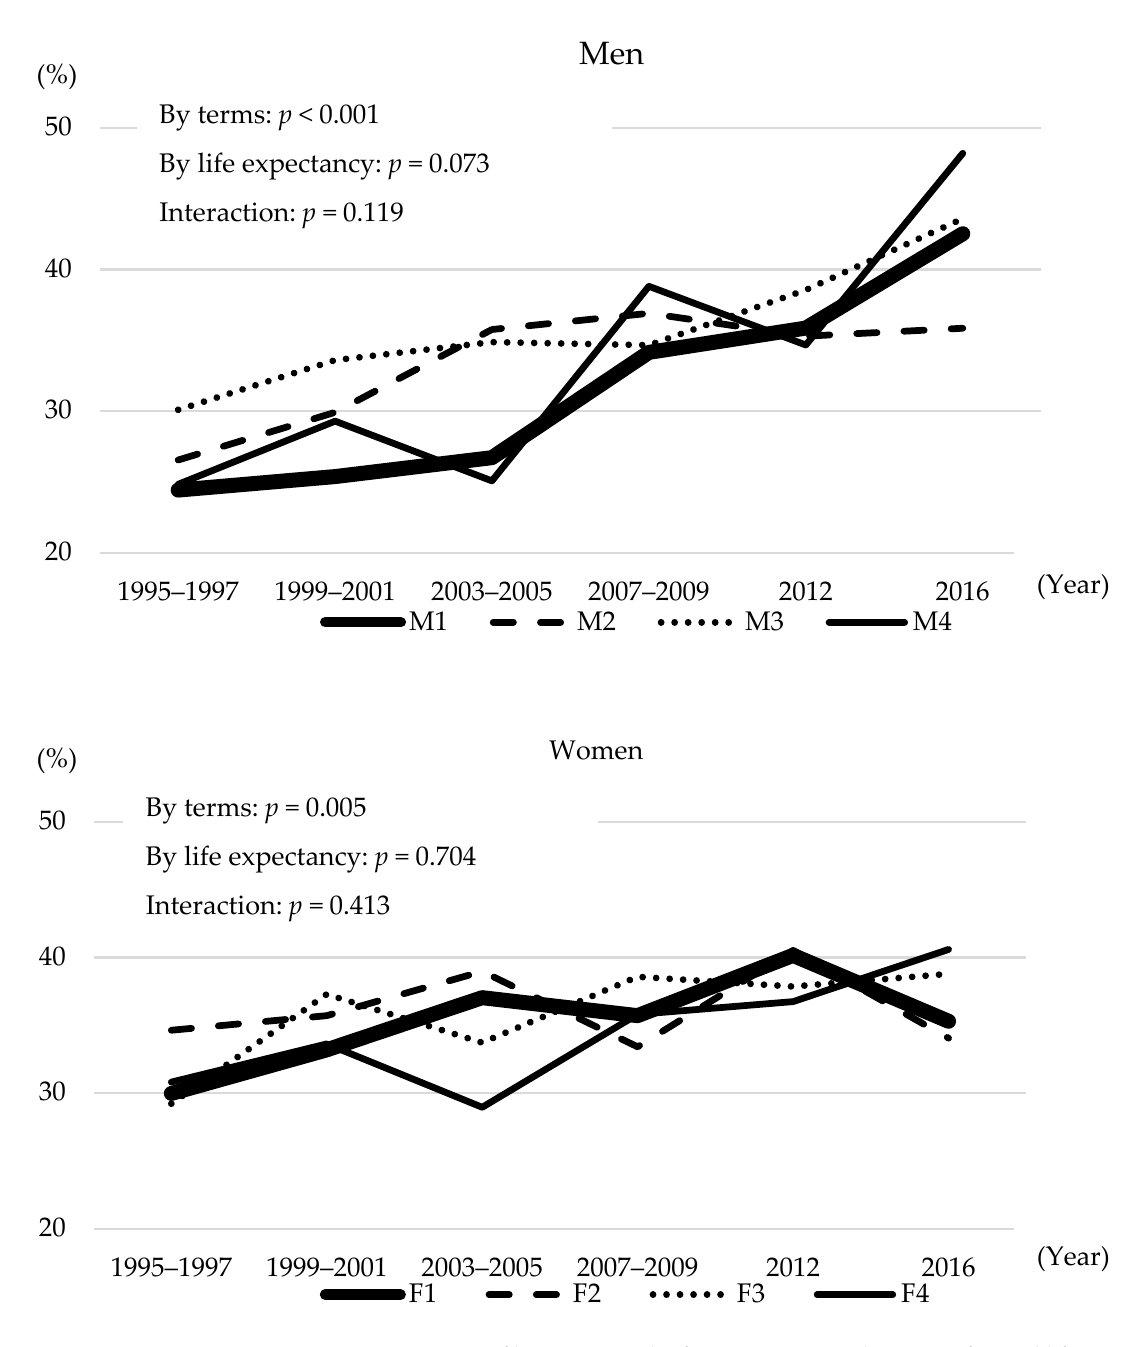
Figure 2. Treatment rate of hypertension by four groups according to prefectural life expectancy. The age-standardised control rate of hypertension by terms was increasing among both men ( p < 0.001) and women ( p < 0.001); however, there was no significant association between the age-standardised control rate of hypertension and life expectancy among men ( p = 0.991) and women ( p = 0.504) (Figure